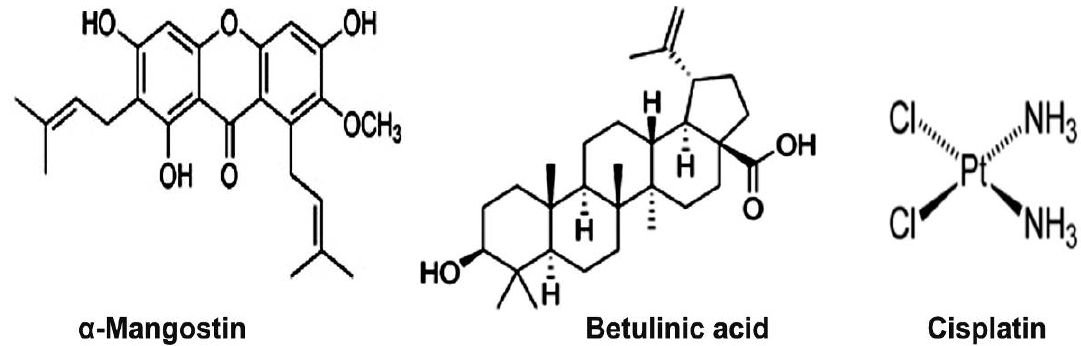
Figure 1. Structure of α -mangostin, betulinic acid, and